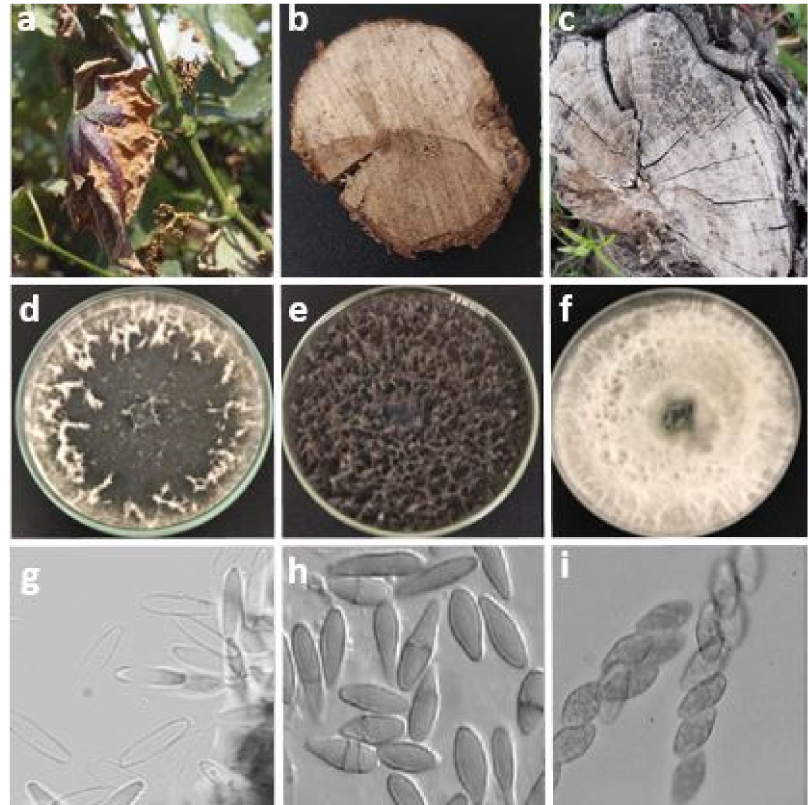
Figure 5. ( a ) Characteristic symptoms of Botryosphaeria dieback leading to leaf fall; ( b ) detail brown band and vessels obstructed by yellowish material; ( c ) grey sectorial necrosis; ( d – f ) appearance of the mycelia of Botryosphaeria dothidea , Botryosphaeria stevensii and Neofusicoccum parvum after 7 days incubation; ( g – i ) aspects of conidia of Botryosphaeria dothidea , Botryosphaeria stevensii and Neofusicoccum parvum,